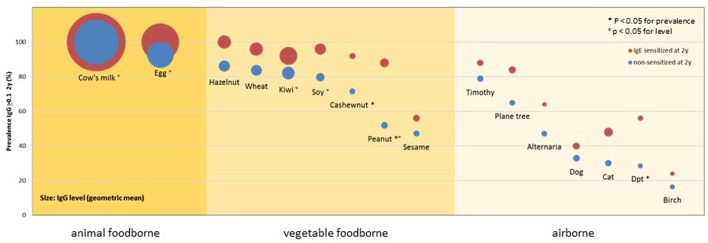
Prevalence and levels of IgG responses to allergenic sources in 148 children of the MAS cohort at 2 years of age by IgE sensitization at 2 years of age and main exposure route. Circles show the prevalence (y-axis) and levels (diameter) of detectable IgG responses (≥0.1 ISU) to allergenic sources in children with (red) or without (blue) IgE sensitization at 2 years of age. P-values refer to comparisons of the prevalences and levels [reprinted from (5), Copyright 2016, with permission from Elsevier].